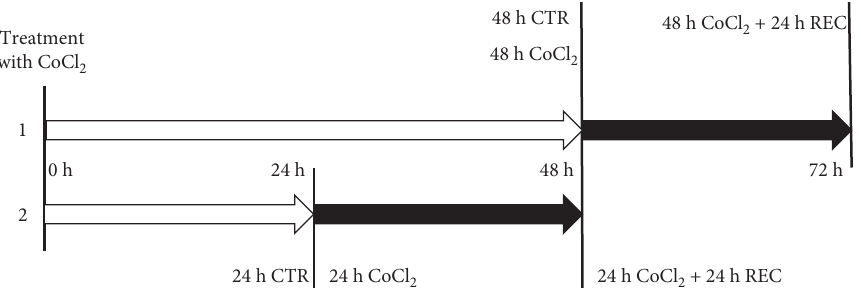
Figure 1: Schematic representation of two CoCl 2 treatments. (1) Exposure of MIO-M1 cells to 100 µ M CoCl 2 for 48h followed by 24 h of recovery in a complete medium (DMEM+10% FBS+ 1% L-Glut+1% Pen/Strep). (2) 24 h exposure to 100 µ M CoCl 2 followed by 24h of recovery. CTR: control sample. White arrow: medium added with CoCl 2 . Black arrow: medium without CoCl 2 . Black vertical lines indicate timepoints of cell collection.